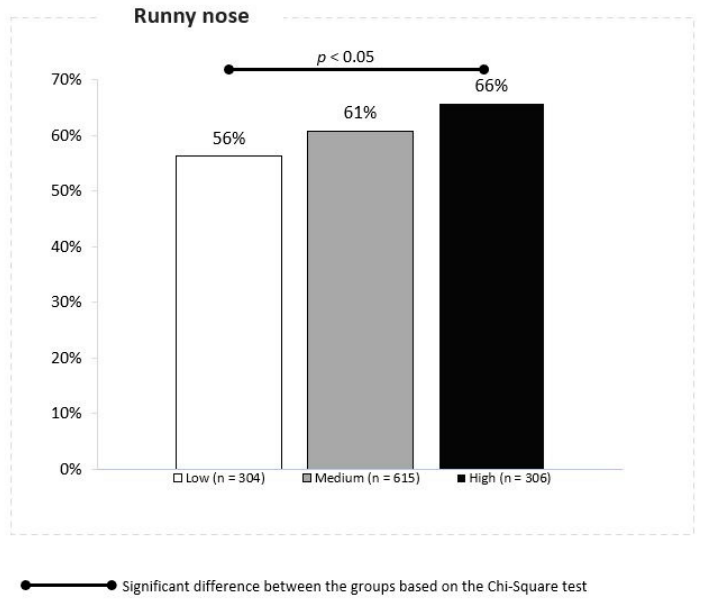
Figure 2. Association between the PM 10 concentrations and runny nose.